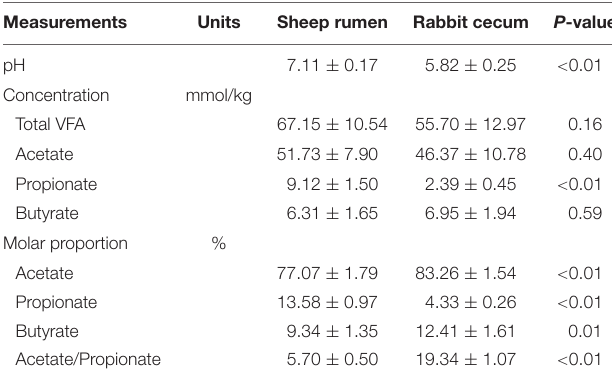
TABLE 2 | Fermentation characteristics of the sheep rumen ( n = 5) and the rabbit cecum ( n = 15).